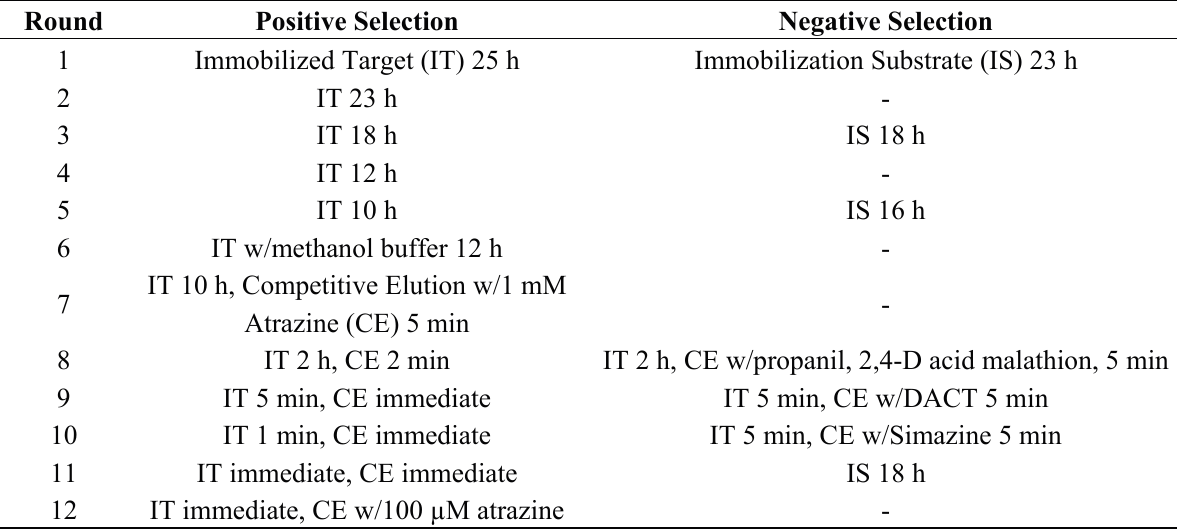
Table 1. Systematic Evolution of Ligands by Exponential Enrichment (SELEX) scheme for atrazine molecular recognition element (MRE)